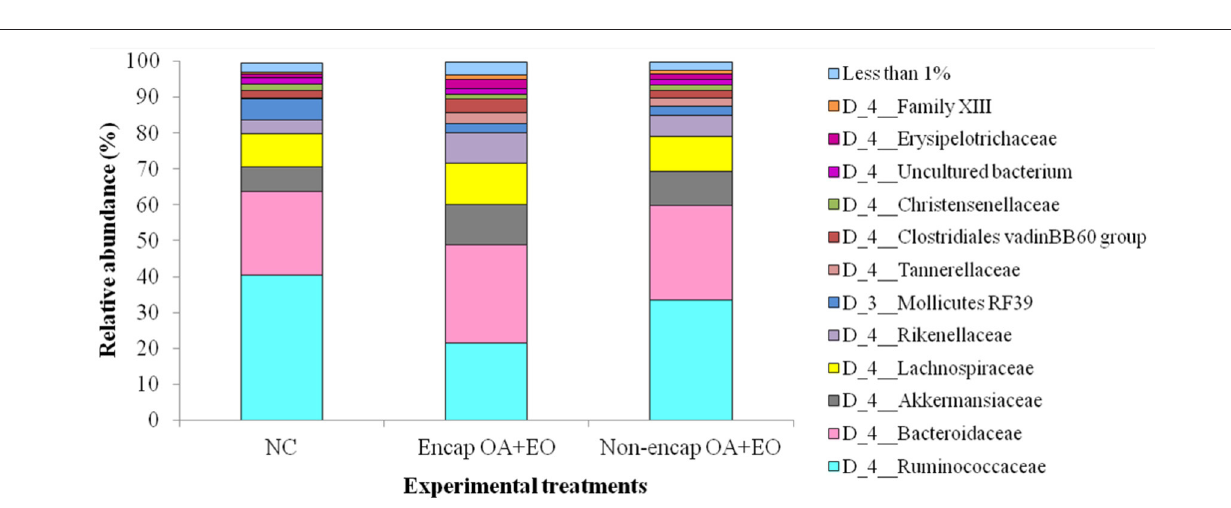
FIGURE 5 | Abundant bacterial families present in the cecum microbiota of broilers from different treatment groups on day 35. NC, negative control; OA, organic acid: fumaric; EO, essential oil: thymol. Encap: microencapsulated; Non-encap, non-microencapsulated. Inclusion levels: microencapsulated fumaric acid: 1.5 g/kg; microencapsulated thymol: 3 g/kg; non-microencapsulated fumaric acid: 0.9 g/kg; non-microencapsulated thymol: 0.6